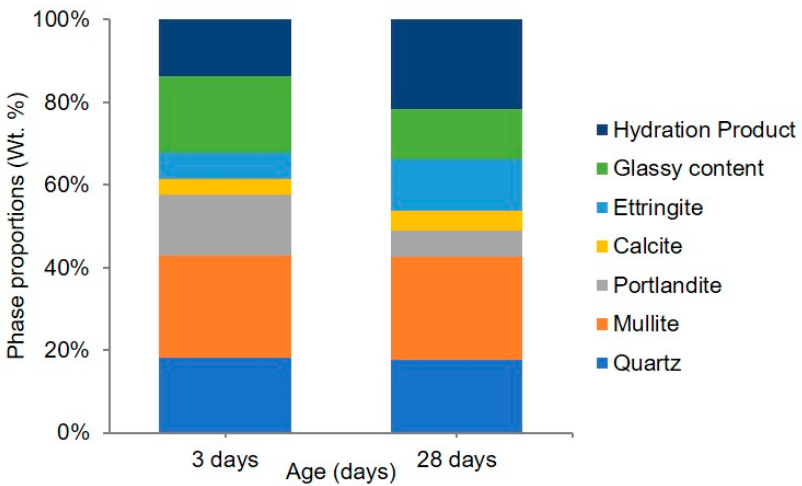
Figure 10. The different quantified phases of the NM mix at 3 and 28 days. Figure 10. The di ff erent quantified phases of the NM mix at 3 and 28 days.